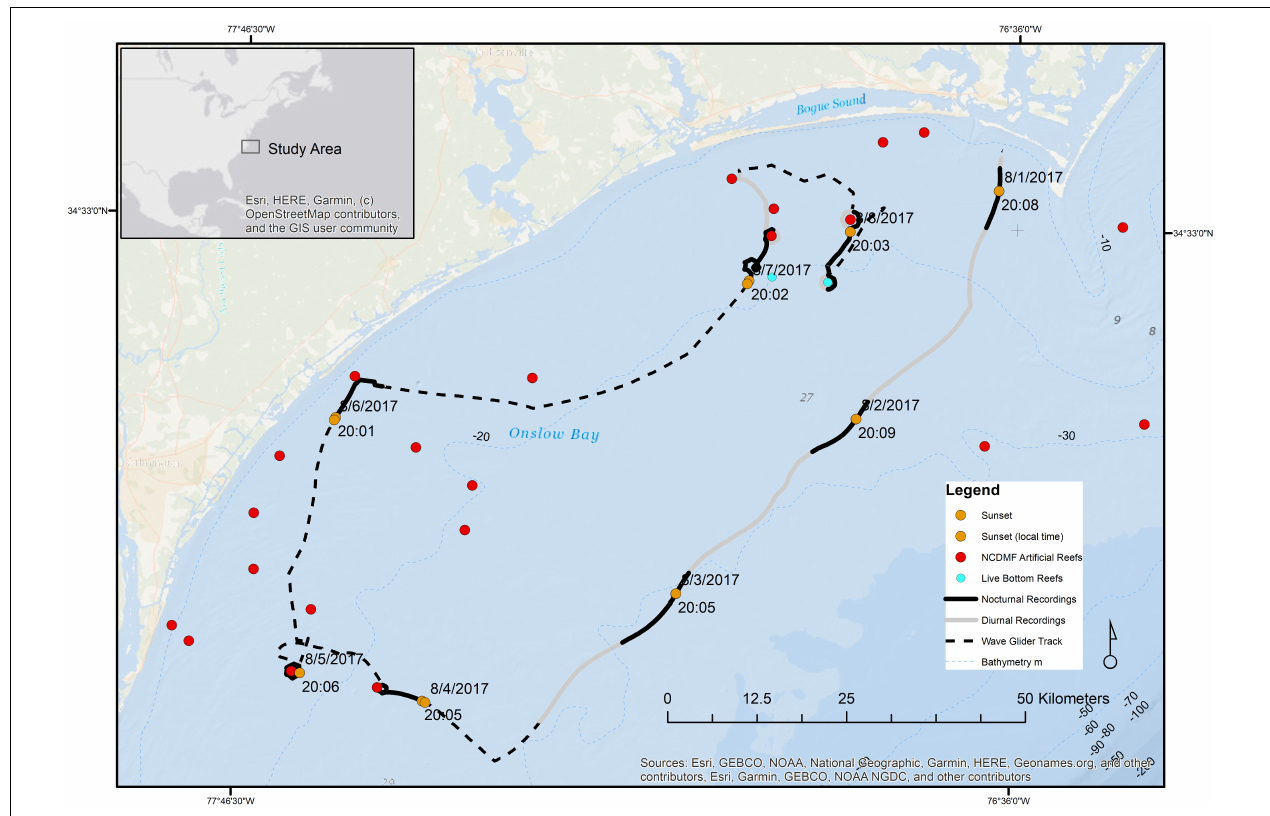
FIGURE 2 | The track of the wave glider deployed August-01 through August-09 off North Carolina (United States) in Onslow Bay. The black dashed line shows the track of the wave glider, with nocturnal recordings shown as heavy black lines, and daytime recordings shown as gray lines, orange points show the position of the wave glider at sunset each day (in local time), the red points showing artificial reefs (North Carolina Artificial Reef Program, data source http://portal.ncdenr.org/web/mf/artificial-reefs-program), and cyan points showing live bottom reef areas. Bathymetry is in m, with 10 m contours shown as light bluedashed